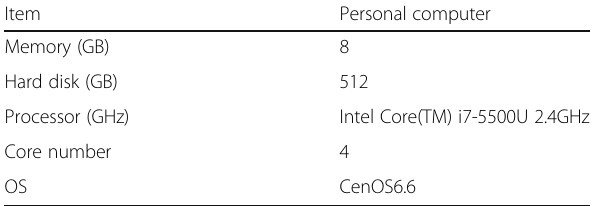
Table 1 Cloud platform